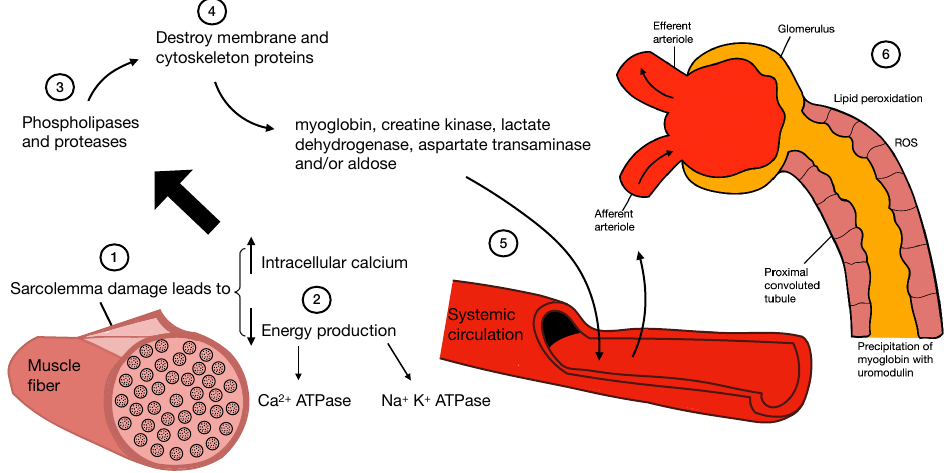
Figure 5. Pathophysiology of kidney damage induced by